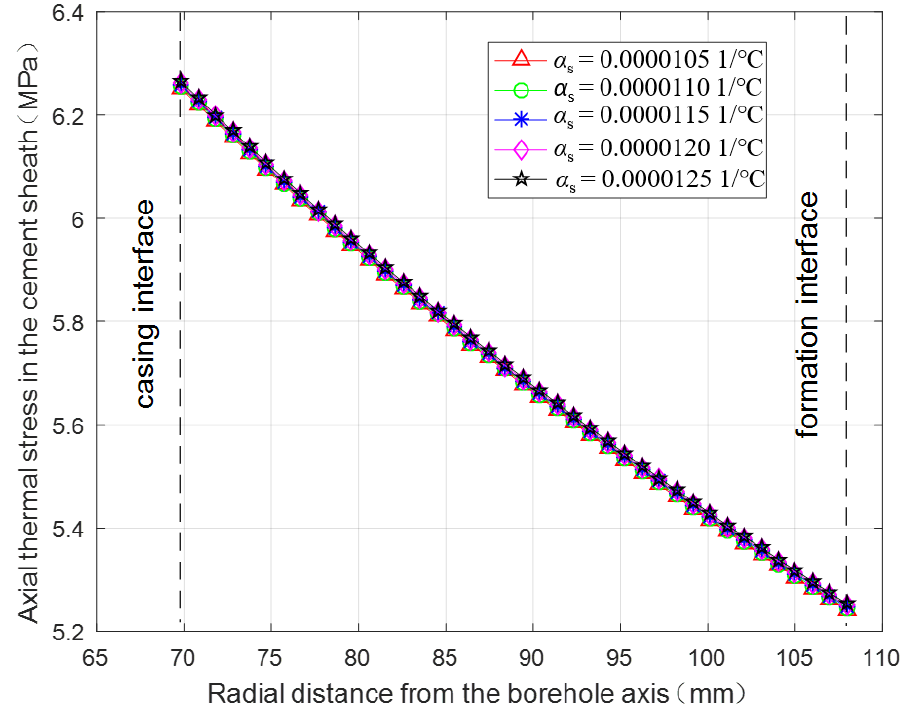
Figure 9. Radial distribution of the axial thermal stress in the cement sheath under different linear thermal expansion coefficients of the casing.